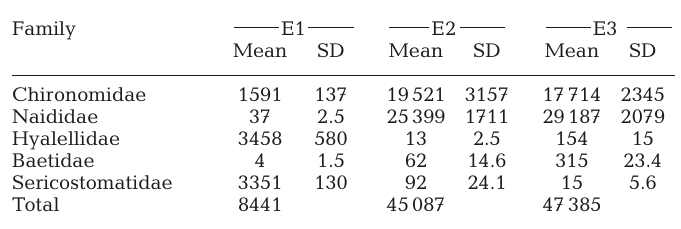
Table 2. Abundance (ind. m −2 ) per family, representing 90% of the benthos